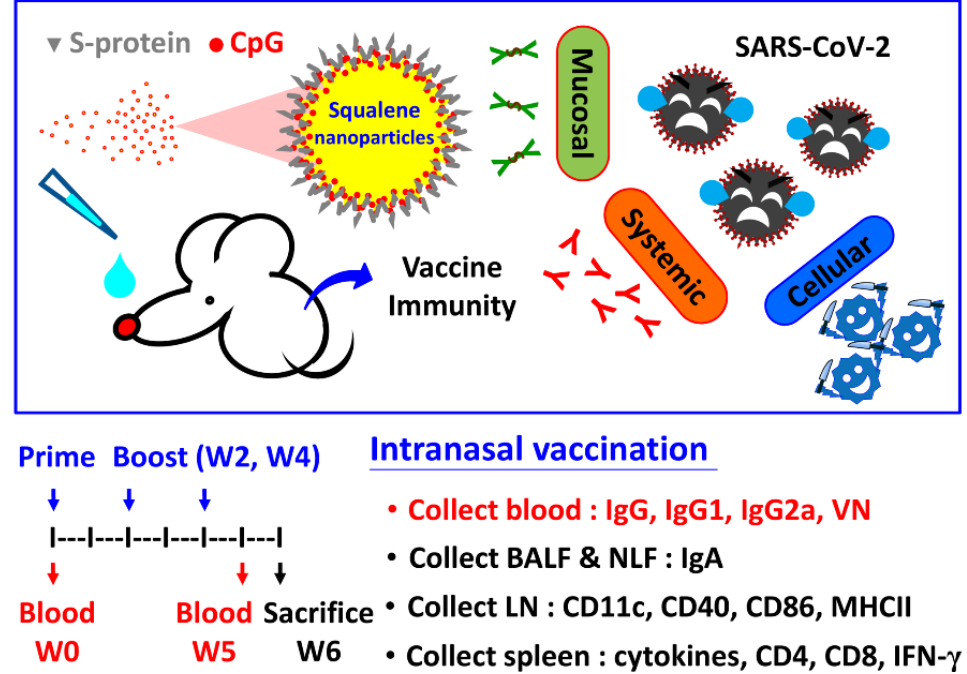
Figure 1. Schematic representation and immunogenicity study design of CpG- and PELC-adjuvanted COVID-19 vaccines. PELC:CpG is a combination adjuvant comprising PELC squalene nanoparticles and CpG oligodeoxynucleotides. Following intranasal delivery, PELC act as antigen carriers to facilitate the transportation of antigen and CpG across nasal mucosal membrane to mucosal-associated lymphoid tissue and trigger vaccine immunogenicity. Mice were intranasally (i.n.) administered full-length SARS-CoV-2 spike subunit protein, either with CpG, PELC, or their combination. At week 2 and week 4, all mice were boosted i.n. with the same vaccine formulations. Draining LNs were harvested to determine antigen-presenting cell (APC) activation. Blood, NLF, BALF, and spleen collections were performed to determine systemic, mucosal, and cell-mediated responses.